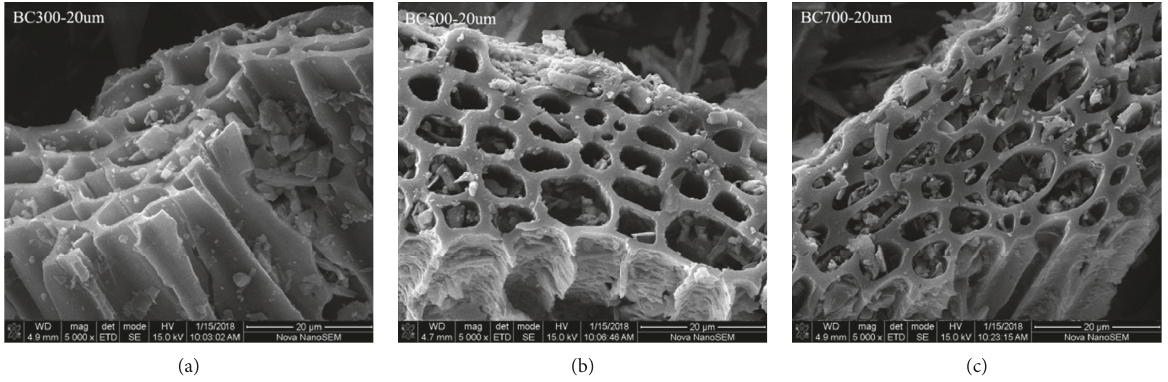
Figure 1: Scanning electron microscopy (SEM) images of BC300, BC500, and BC700.